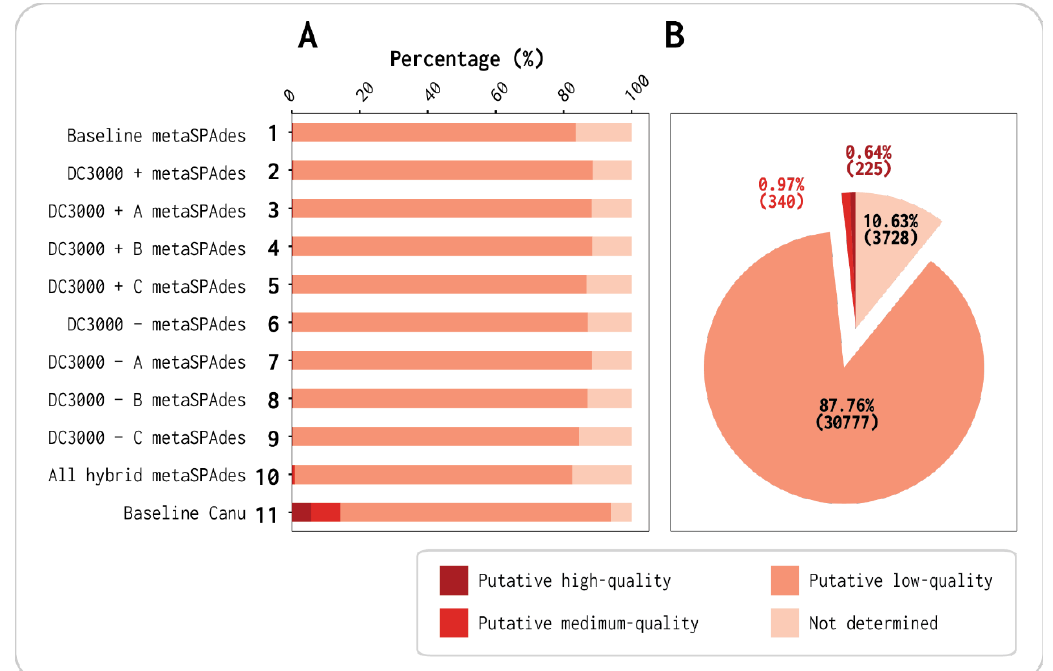
Figure 2. Quality identification by viral contigs with CheckV: ( A ) percentage of quality distribution of viral contigs in each